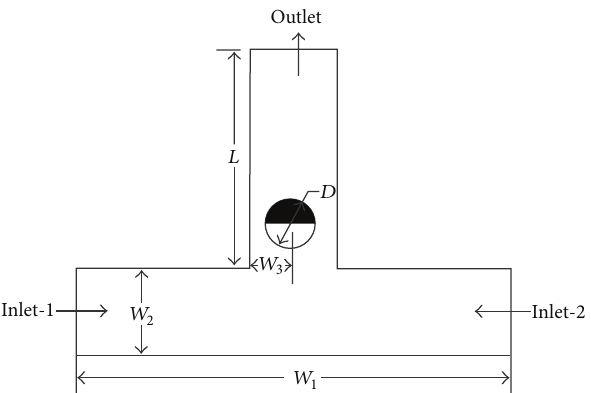
Figure 1: Schematic diagram of the T-shaped microchannel with Janus cylinder.